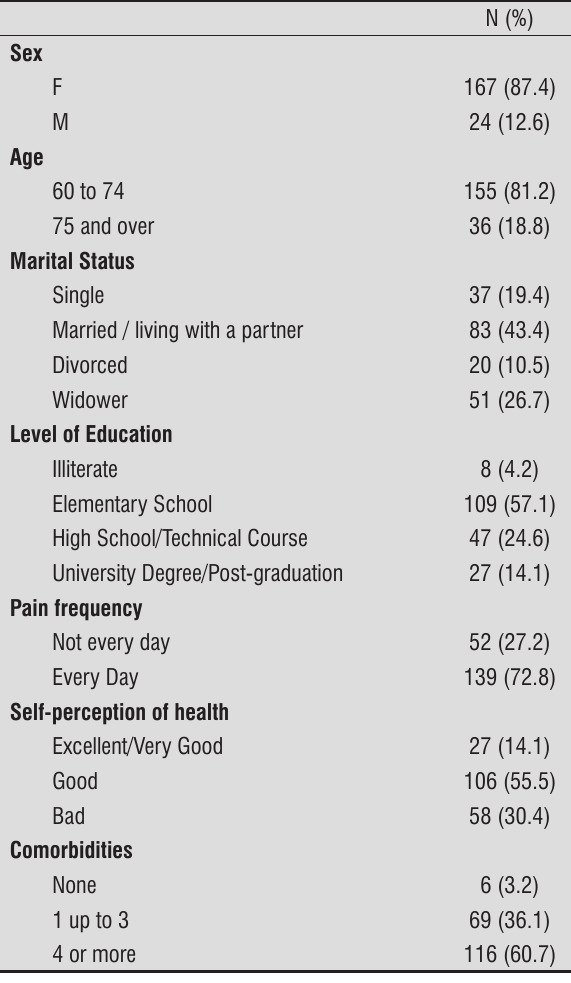
Table 1 - Demographic, clinical and self-perceived health characteristics of participants (n = 191)